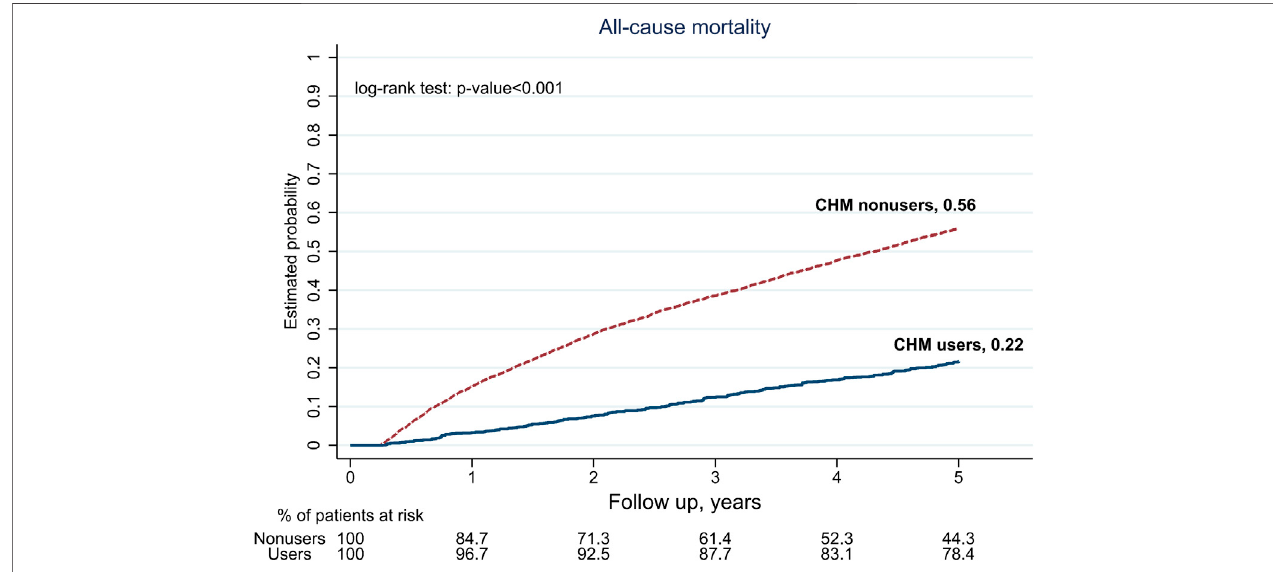
FIGURE2| 5-yearfollow-upforall-causemortalityamongpre-dialysisdiabeticnephropathy(DN)patients,byChineseherbalmedicine(CHM)usersandnonusers.